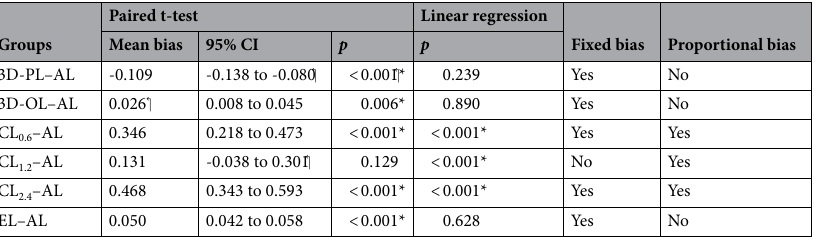
Table 2. Mean biases, confidence intervals, p values in two statistical tests, fixed or proportional biases between experimental methods and AL measurements. *Differences at significant level of 0.05. 3D-PL: Proposed length; 3D-OL: Operator length; EL: Electronic length; AL: Actual length. CL 0.6 : CBCT length at slice thickness of 0.6 mm. CL 1.2 : CBCT length at slice thickness of 1.2 mm. CL 2.4 : CBCT length at slice thickness of 2.4 mm.